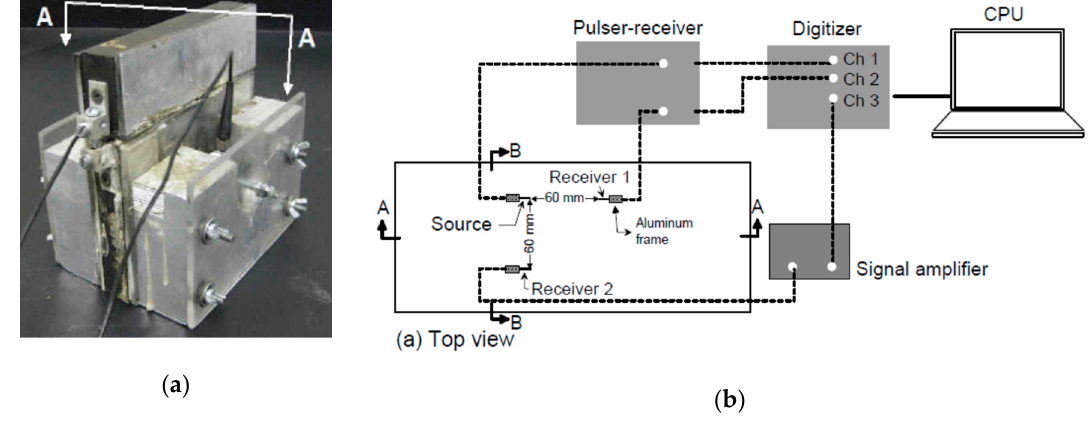
Figure 12. [102] ( a ) Top view of all test systems. ( b ) Frame of the test system.